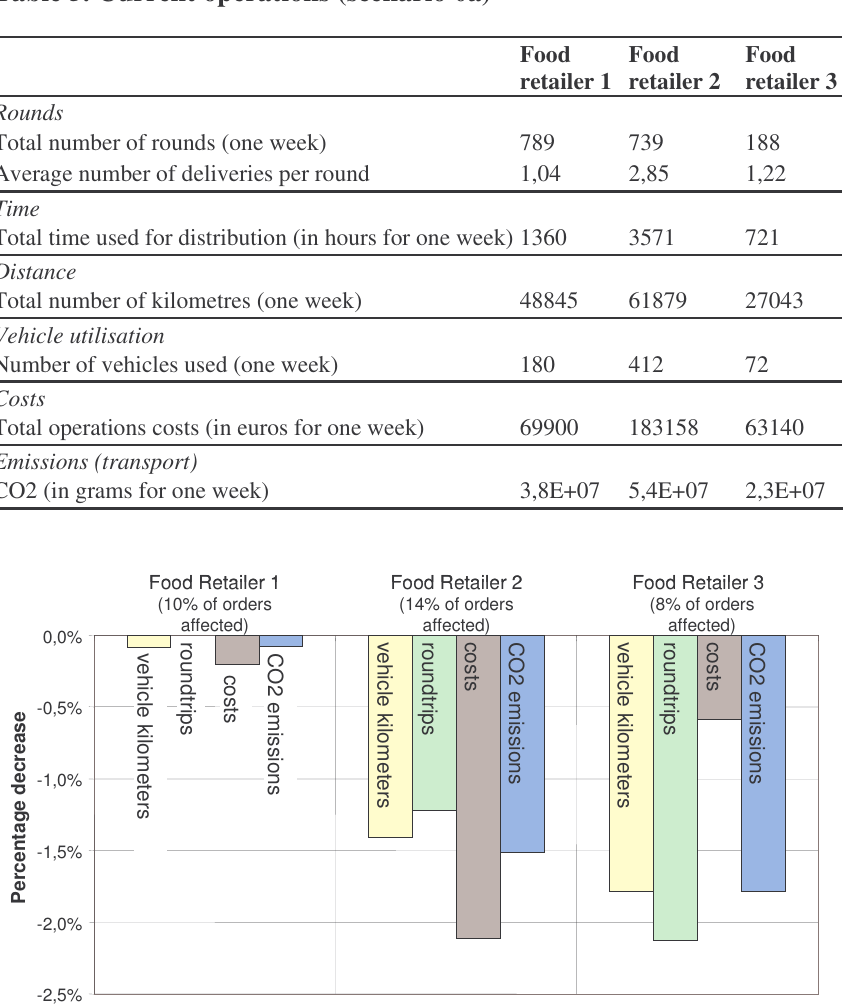
Table 5. Current operations (scenario 0a)